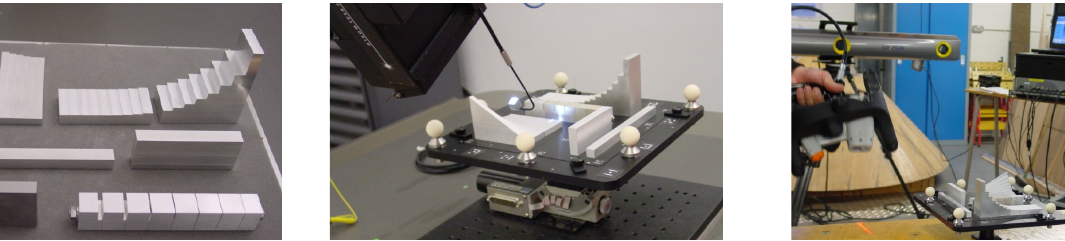
Figure 12. Nikon handheld MMD and Krypton K610 Camera for 3D scanning